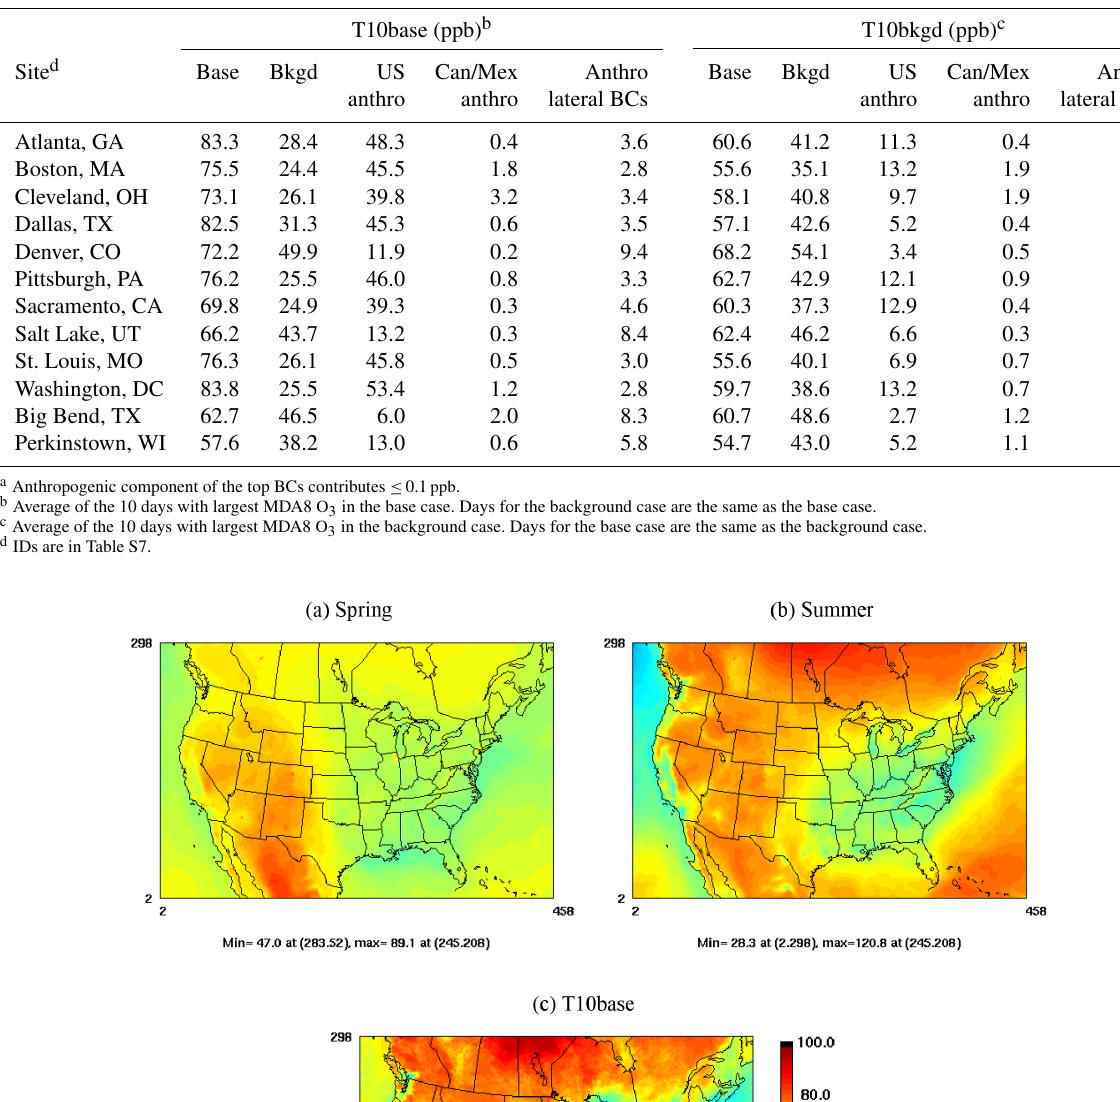
averages. For the largest O 3 concentrations (T10base), Den- ver, Salt Lake, and Big Bend have the largest ratios (69, 66, and 74 %, respectively) and Boston, Pittsburgh, and Wash- ington, DC, the smallest ratios (32, 33, and 30 %, respec-